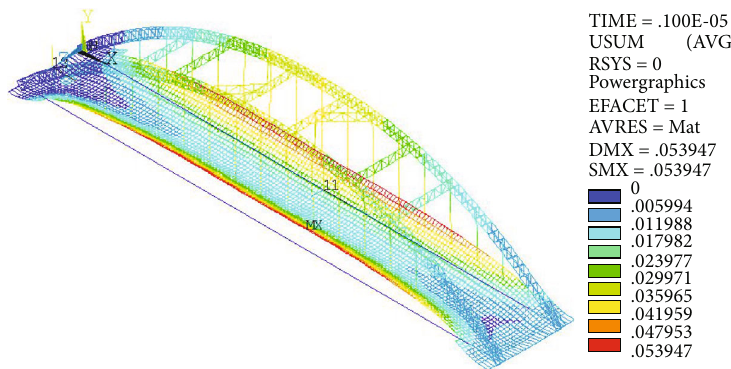
Figure 12: The overall displacement cloud map of arch bridge under case 1 (m).